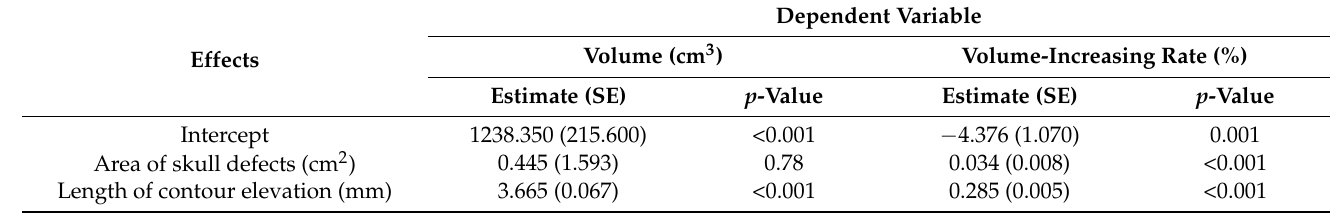
Table 4. Parameter estimation for volume and volume-increasing rate of 15 CAD models based on length of contour elevation and areas of skull